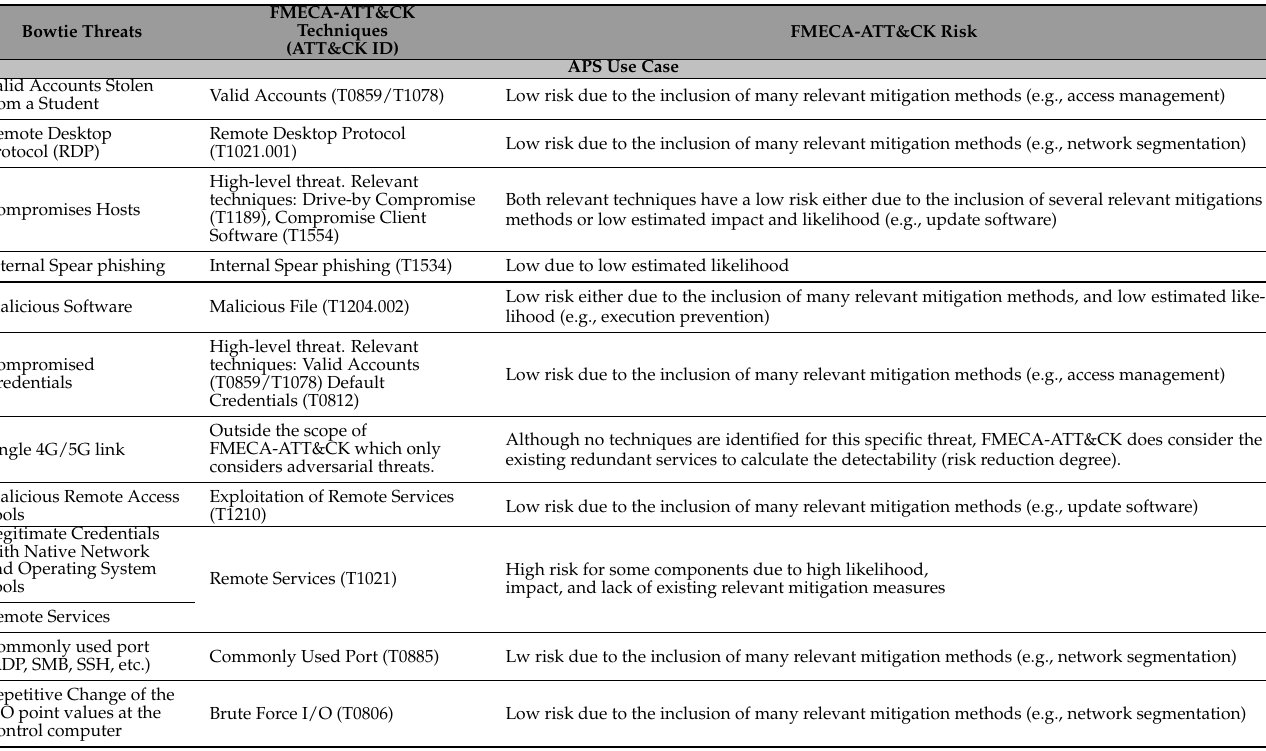
Table 3. The relations between the top risks identified through Bow-Tie and